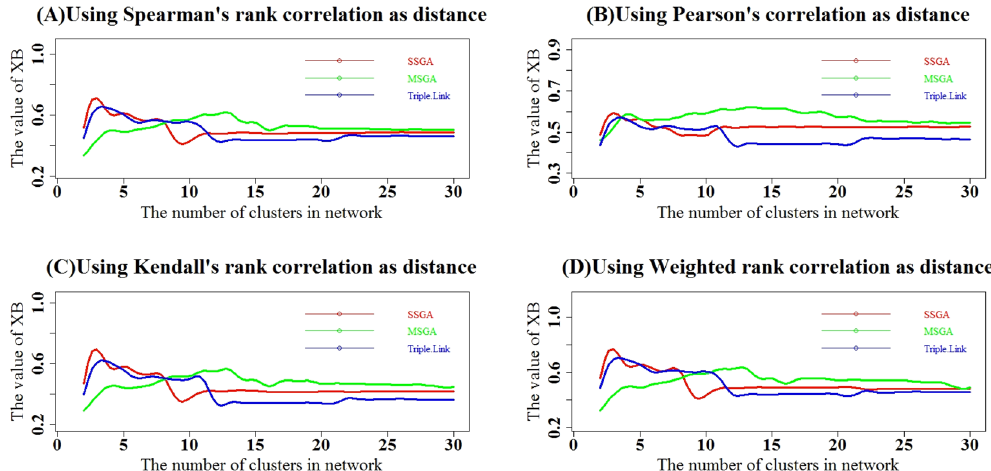
Figure 8. Comparison of subnetworks derived from SSGA, MSGA and Triple-Link Algorithm with XE indices. The XE indices of top i subnetworks derived from SSGA, MSGA and Triple-Link Algorithm where i = (2, … , 29, 30). The XE indices were calculated with Spearman rank correlation coefficients as distances ( A ), Pearson product-moment correlation ( B ), Kendall’s rank correlation ( C ) and Weighted rank correlation ( D ). In all the cases, a higher XE * index represents a greater degree of coordination in the top i subnetworks. In all the cases, a higher XE index represents a greater degree of coordination in the top i